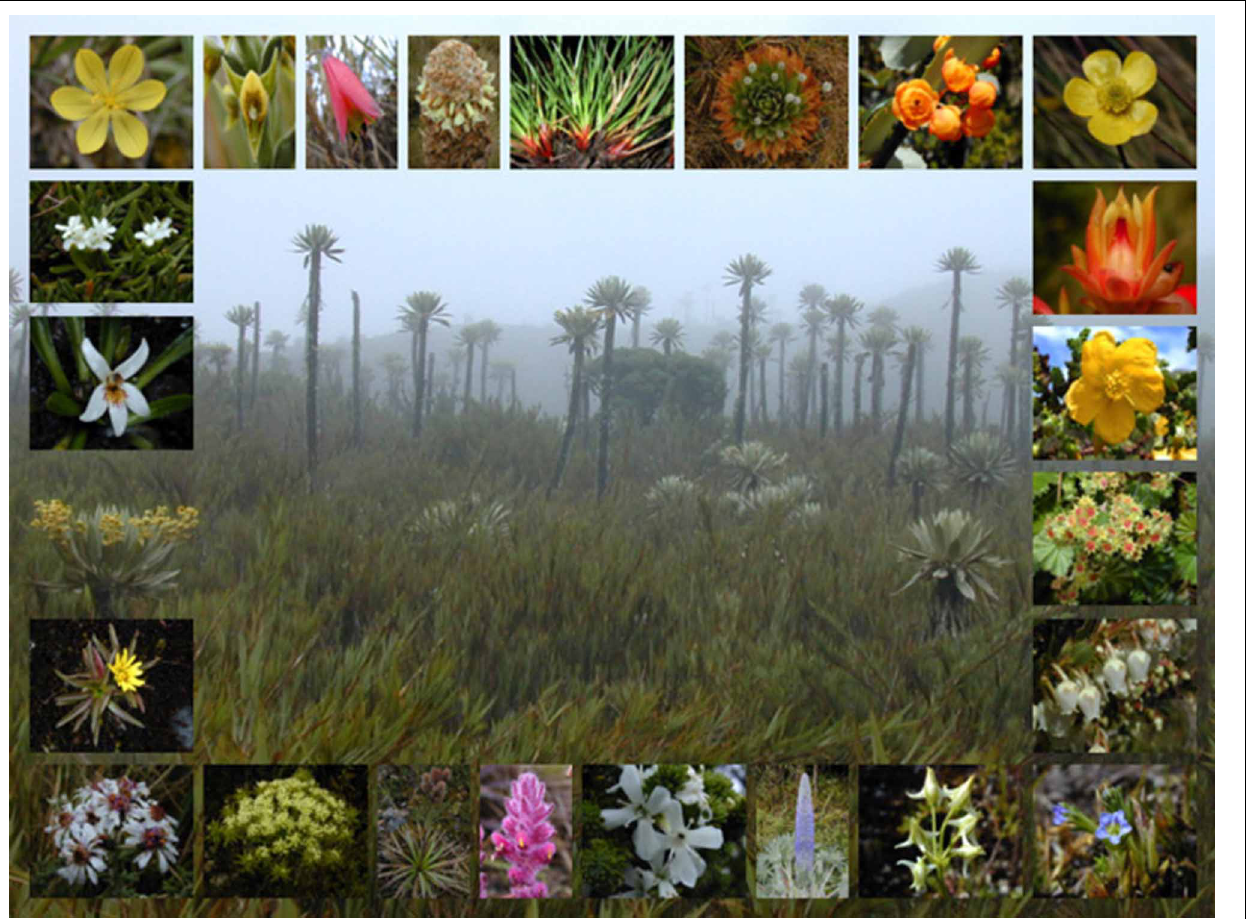
FIGURE 2 | Plants of the Páramos. Center: Páramo landscape with Chusquea tessellata (foreground) and Espeletia uribei (background): Frame (clockwise from top left): Sisyrinchium convolutum , Pterichis habenarioides , Bomarea pauciflora , Puya trianae , Oreobolus goeppingeri , Paepalanthus alpinus , Berberis goudotii , Ranunculus peruvianus , Echeveria bicolor